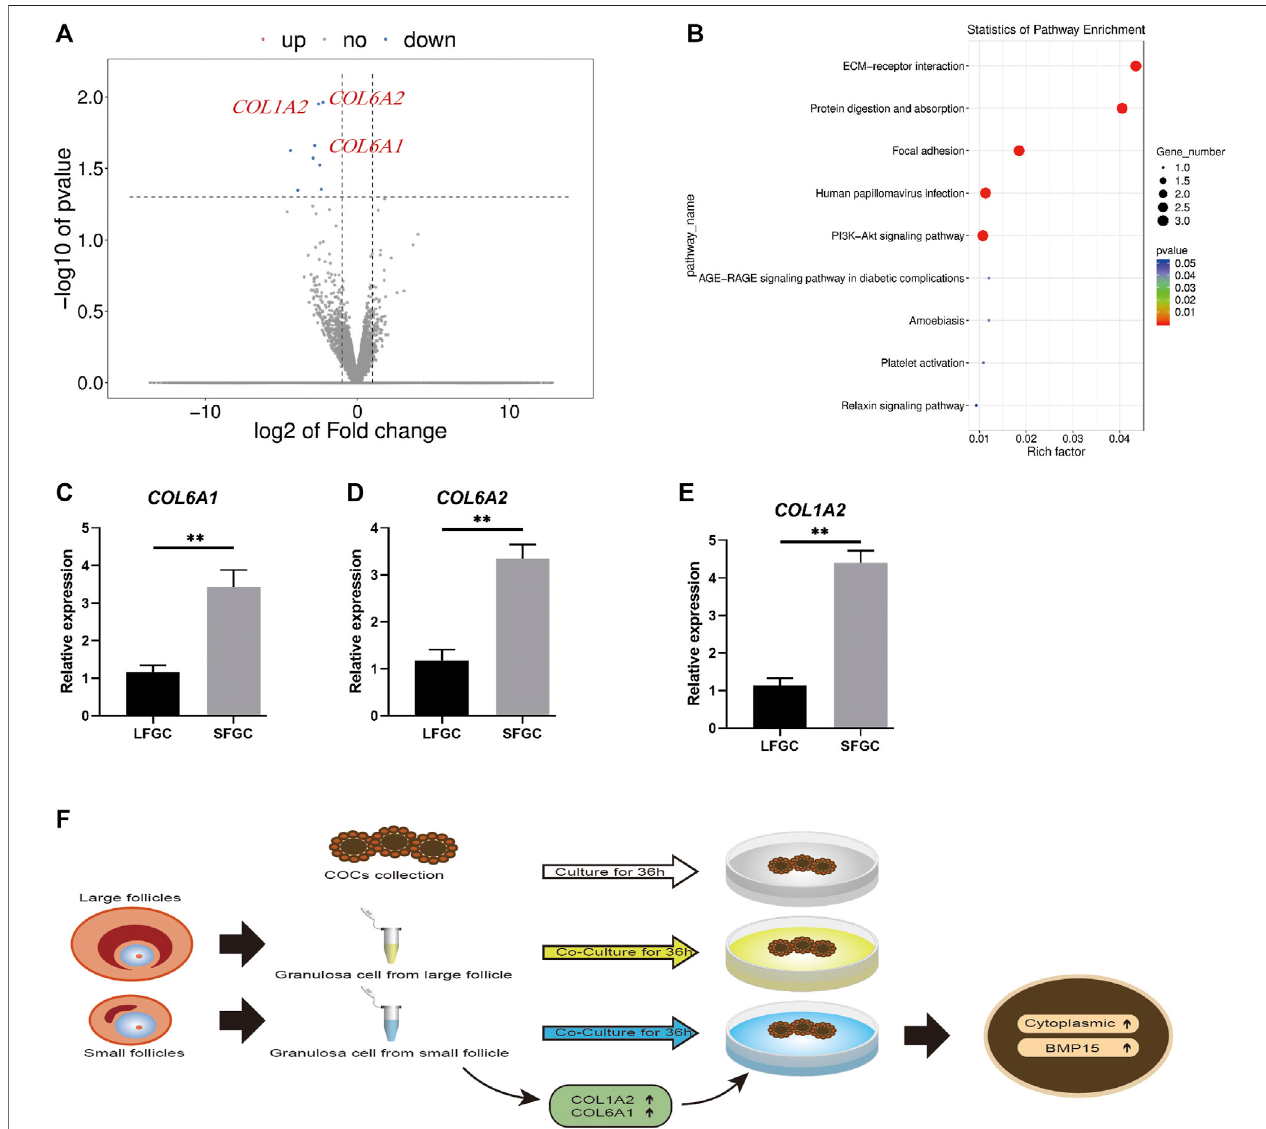
FIGURE6| mRNAexpressionpro fi lesofgranulosacellsandvalidationofdifferentiallyexpressedmRNAsbetweengranulosacellsfromsmallandlargefollicles. (A) Volcano map displaying DEGs between the granulosa cells from small follicles and those from large follicles. (B) KEGG pathway analysis of common DEGs. (C – E) Relative expression levels of COL1A2 , COL6A1 , and COL6A2 in large and small follicle – derived granulosa cells were evaluated using q-PCR. (F) Speculative model for the bene fi cial effect of GCs on the cytoplasmic maturation of mare oocytes in vitro .